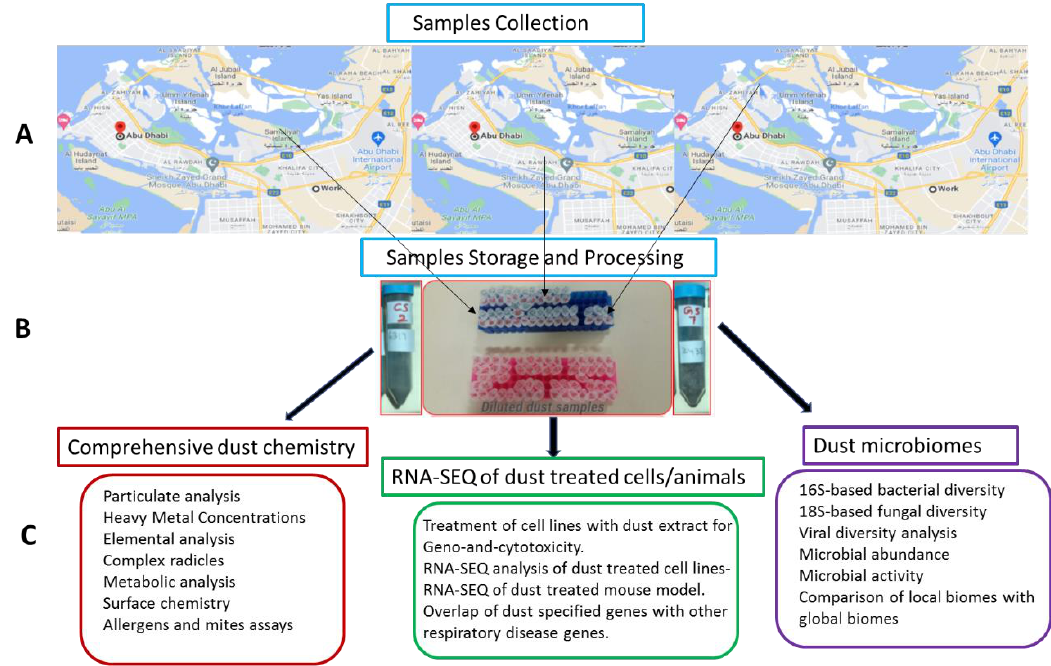
Figure 2. A unified framework to assess the health effects of indoor dust by applying an integrated meta-analysis. Figure legend: schematic representation of the meta-analysis of indoor dust effects on occupants. Inclusive sampling across multiple locations with accurate location and coordinates in the study zone ( A ). The collected samples are properly archived and stored to avoid degradation and contamination ( B ). Analytical and microscopic techniques are applied to study the chemical and particulate nature of indoor dust. Microbial diversity, abundance and activity of dust is studied by applying metagenomic analysis following next generation sequencing (NGS) approaches ( C